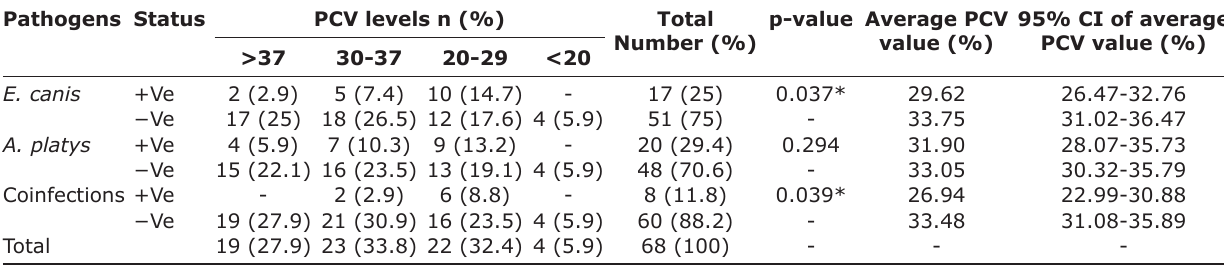
A. platys=Anaplasma platys, E. canis=Ehrlichia canis , CI (%)=95% Confidence interval Table-2: Association among E. canis, A. platys , and coinfections with PCV levels. Pathogens